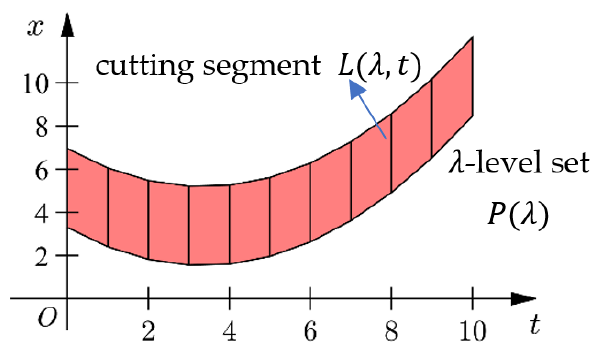
Figure 6. The cutting segment of the 𝜆 -level set in a PFIG.